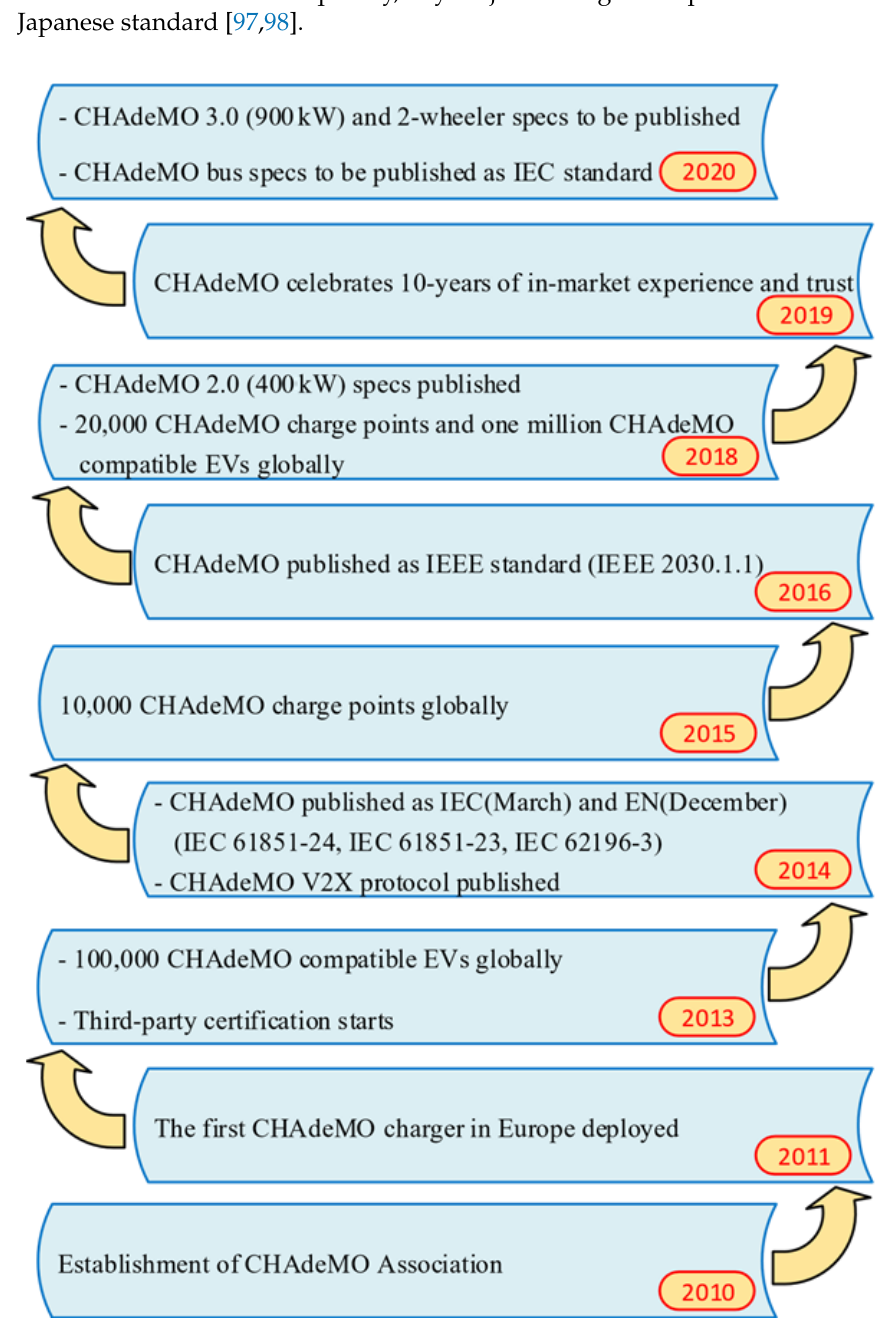
Figure 19. The timeline of the CHAdeMO Japanese standard.